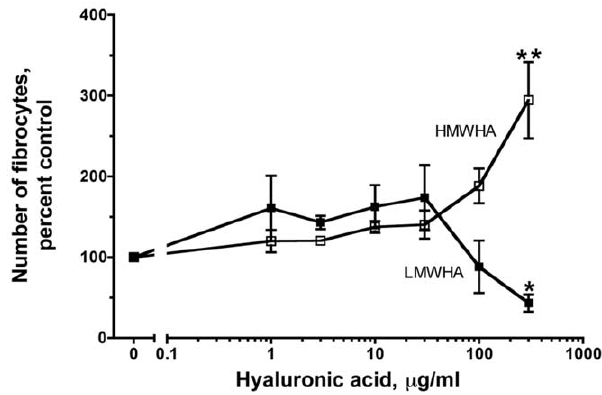
Figure 1. High molecular weight hyaluronic acid (HMWHA) promotes fibrocyte differentiation, while low molecular weight hyaluronic acid (LMWHA) inhibits fibrocyte differentiation. Human PBMC were cultured in the indicated concentrations of